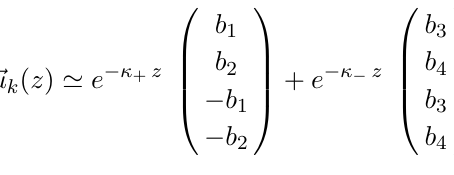
In second term we consider the IR limit; in this case we have to distinguish two